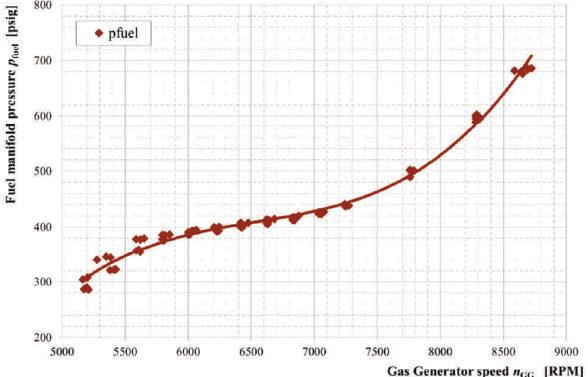
Fig. 12. Approximated function and the results of the measurements of power turbine inlet exhaust gas temperature T 4.1 , recorded for steady-state operation of LM-2500 engine, in relation to gas generator speed n GG